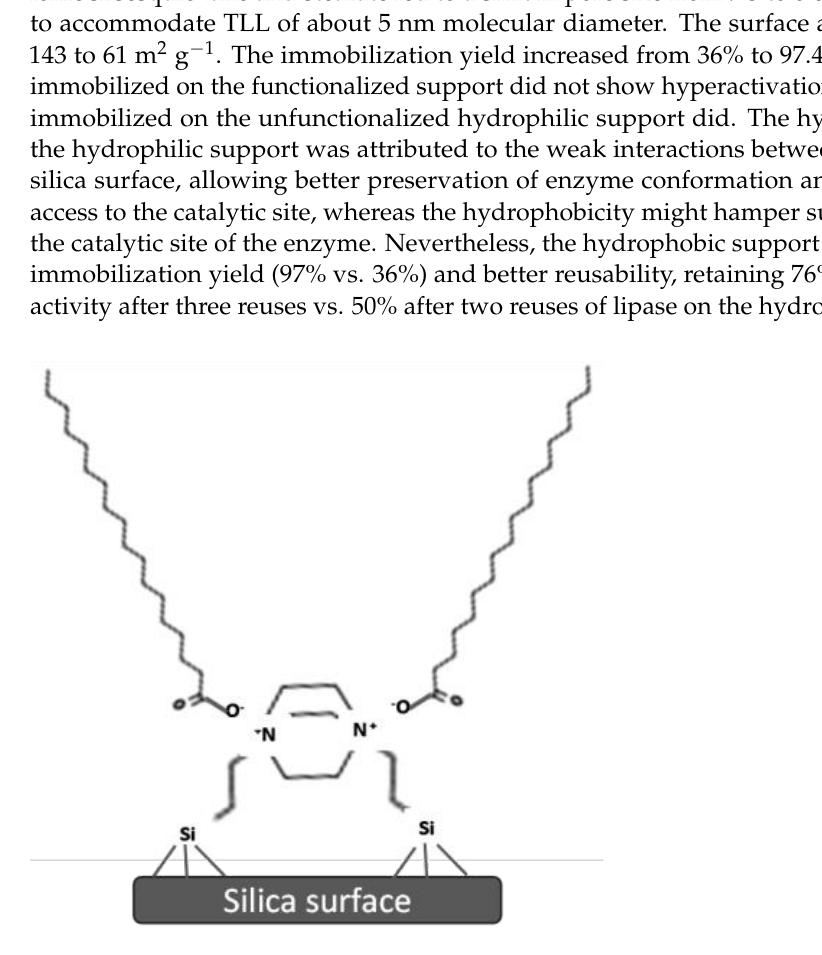
Figure 7. Representation of ionic silsesquioxane having stereate as a counter-ion grafted on the silica surface.